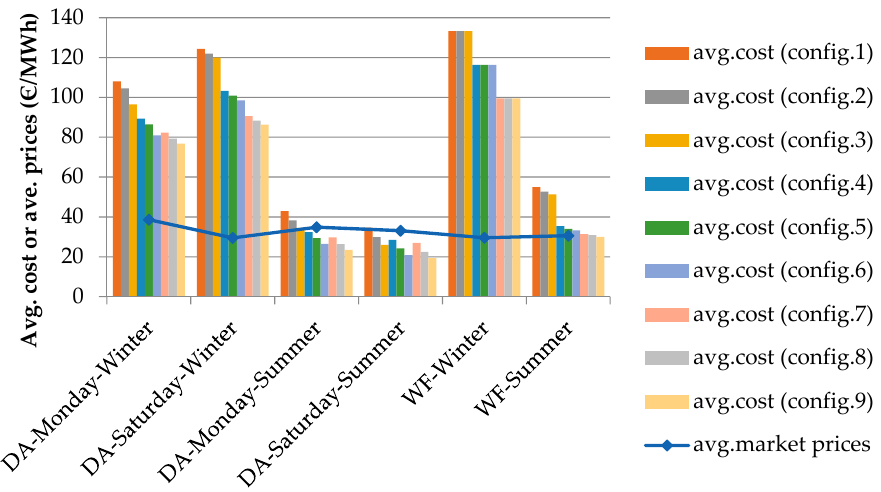
Figure 12. The average VPP’s marginal costs as compared to the average market prices for different market products.